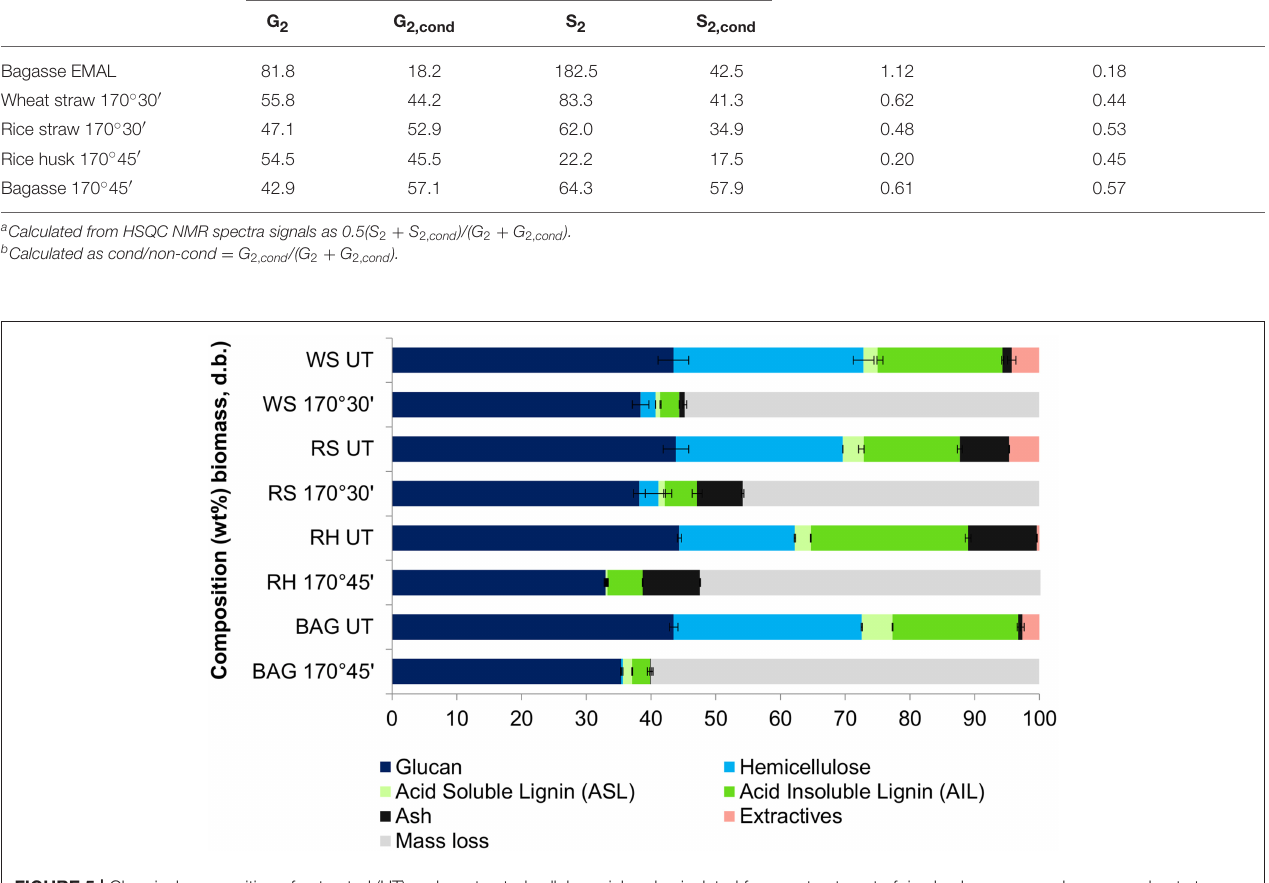
TABLE 3 | Degree of condensation as evidenced by S/G ratio and condensed: non-condensed G 2 ratios of enzymatic mild acidolysis lignin (EMAL) isolated from sugarcane bagasse and for lignins isolated from four agricultural feedstocks with [TEA][HSO 4 ] with 20 wt% water and a biomass to solvent ratio of 1:10 g/g. Lignin